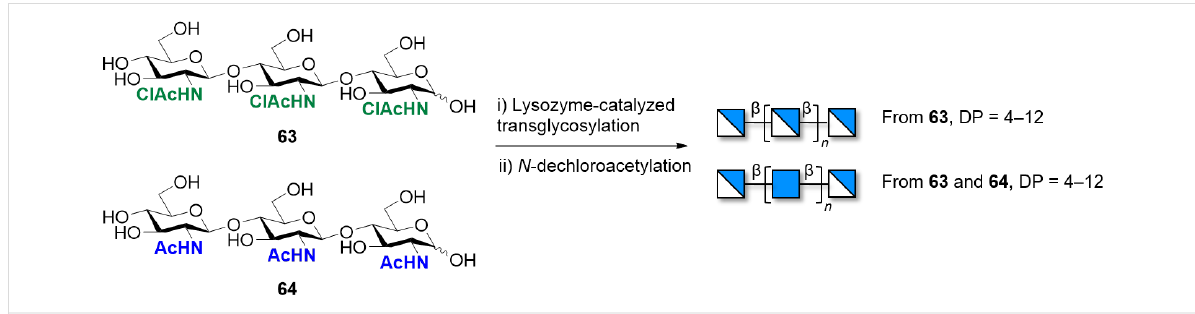
Scheme 9: Chemoenzymatic synthesis of COS utilizing a lysozyme-catalyzed transglycosylation reaction followed by the deprotection of N -chloro-